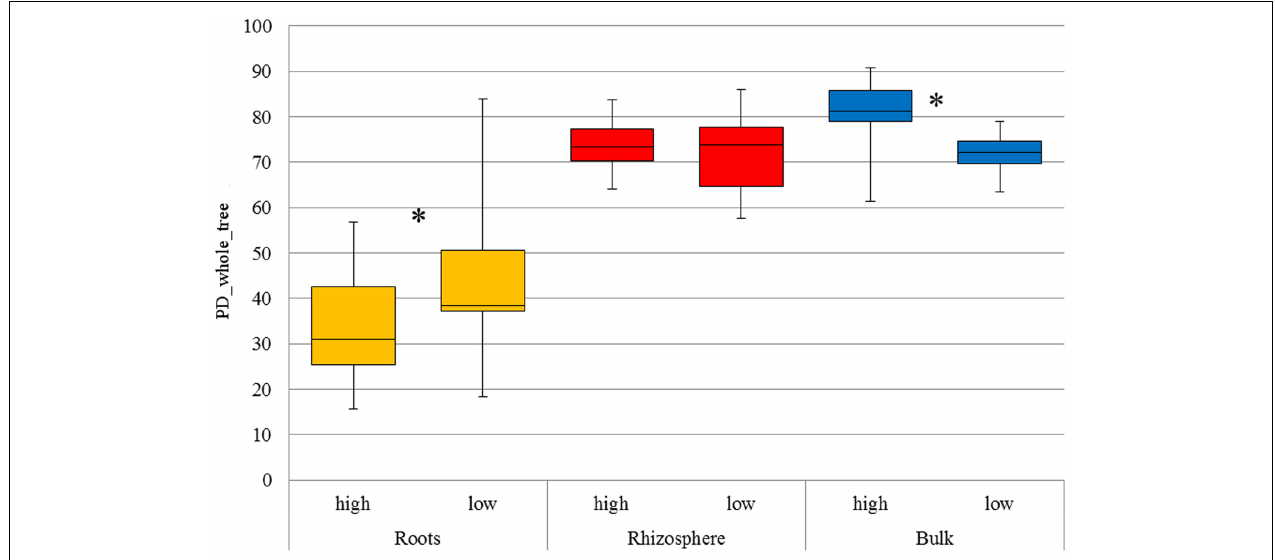
FIGURE 1 | Faith’s phylogenetic diversity of all compartments under low and high land use intensity, respectively. The distribution of phylogenetic diversity is shown at 97% sequence similarity. The boxplot indicates the first and third quartile. The median is indicated as horizontal line and whiskers indicate minimum or maximum, respectively. Significant differences among land use intensities are indicated with an asterisk ( t -test, p <